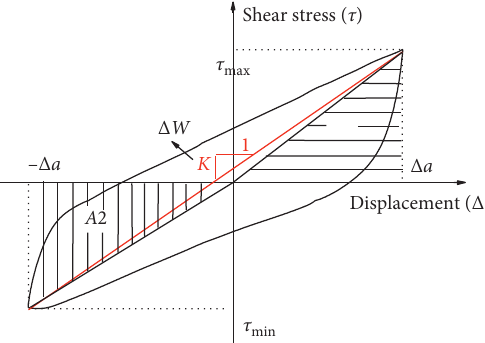
Figure 10: Calculation of the secant shear stiffness and damping ratio from a hysteresis